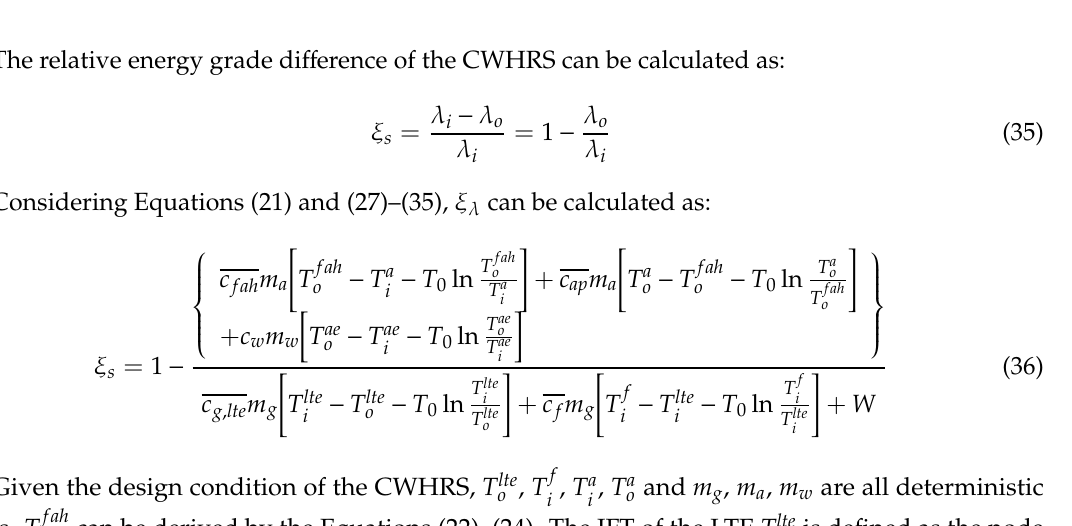
Table 1. Fuel characteristics of the N600-24.2/566/566 unit.